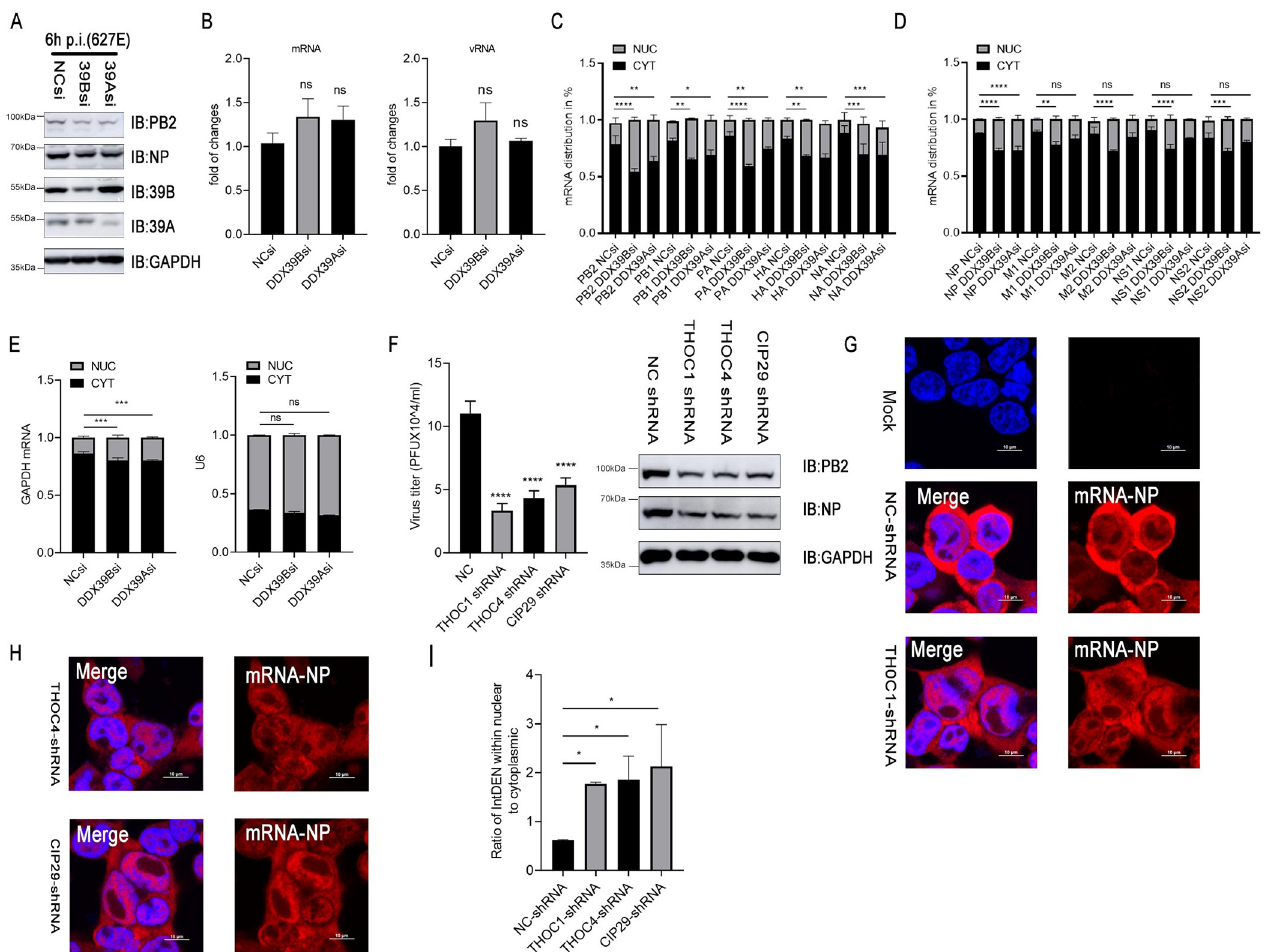
Fig 7. TREX complex are necessary for mRNA nuclear export during the replication of influenza virus. (A and B) HEK293T cells were transfected with the indicated siRNA for 24 h and were infected with the recombinant influenza viruses WSN-H7 (627E) at MOI = 2 without TPCK-trypsin, followed by western blotting to measure the protein levels (A) and qPCR to detect PB2 mRNA or PB2 vRNA at 3h after infection (B). GAPDH served as an internal control. (C, D and E) HEK293T cells were transfected with the indicated siRNA for 24 h and infected with the recombinant influenza viruses WSN-H7 (627E) at MOI = 2. Cells are subjected to nuclear-cytoplasmic separation at 12h after infection and measurements of the viral mRNAs (C and D) and GAPDH, U6 (E) served as an internal control. (F) HEK293T cell lines with shRNA-mediated knockdown of THOC1, THOC4 or CIP29 were infected with recombinant influenza viruses WSN-H7 (627E) at MOI = 0.05. The supernatants were sampled at 24h post infection. The virus titers were determined by plaque assay and protein levels were detected by western blotting. (G and H) HEK293T cell lines with shRNA-mediated knockdown of THOC1, THOC4 or CIP29 were infected with the recombinant influenza viruses WSN-H7 (627E) at MOI = 2. Cells were stained with cy3-labeled NP mRNA probes at 12h after infection, followed by FISH analysis. (I) Quantification of fluorescence signal was performed in ImageJ. Statistical differences between groups are labeled according to one-way ANOVA. The results are presented as means ± standard deviations. � , P < 0.05; �� , P < 0.01; ��� , P < 0.001; ���� , P < 0.0001; ns, no